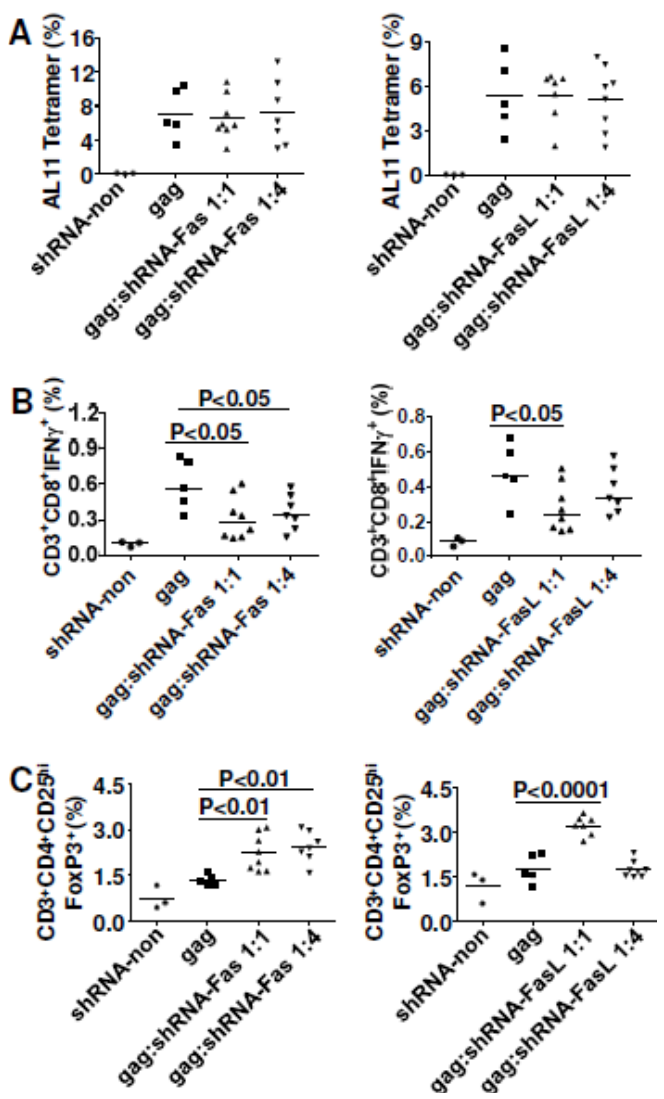
Figure 2. In vivo gene silencing of Fas and FasL did not improve CMI responses for SIVmac Gag. C57BL/6 mice were immunized with 2 μg plasmid pJ603-gag combined with 2 μg or 8 μg plasmids shRNA-Fas or shRNA-FasL at day 0 and day 28. Mice were euthanized ( A ) Tetramer staining; ( B ) Intracellular cytokine staining; ( C ) Regulatory T cell